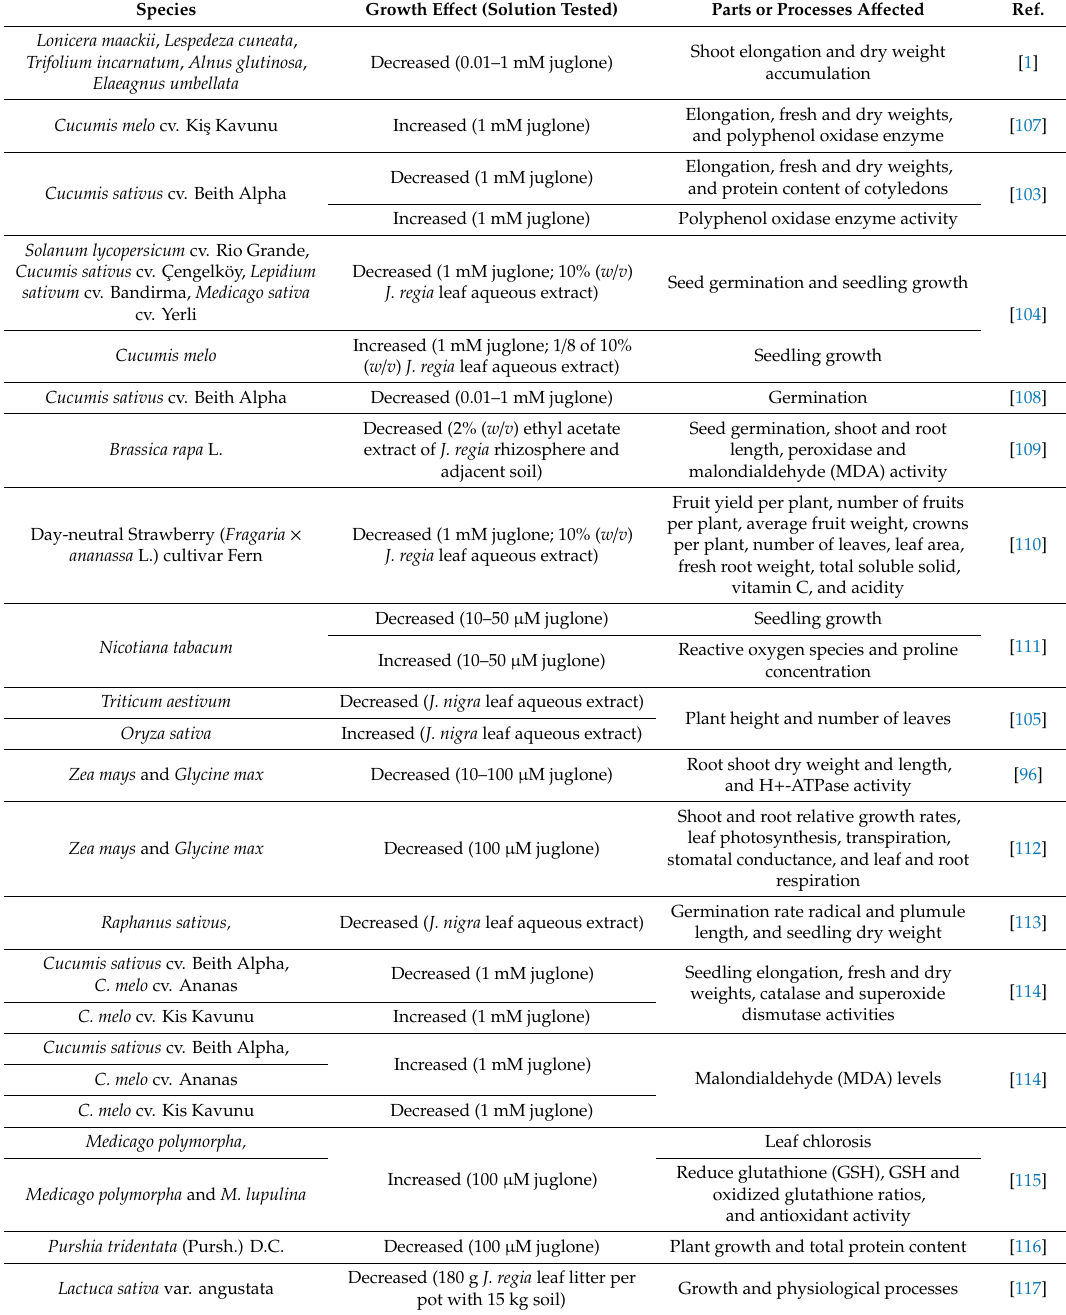
Table 1. Reported e ff ects of juglone or juglone-containing materials on plants. Ref., reference. Species Growth E ff ect (Solution Tested) Parts or Processes A ff ected